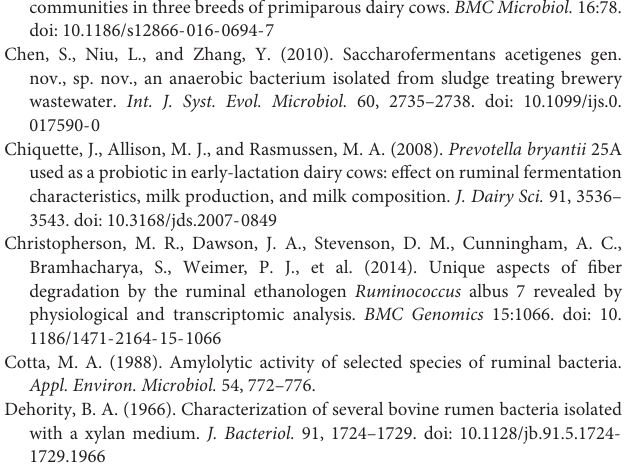
Supplementary Figure 1 | Venn diagram showing OTU distribution. Shared OTUs between milk phenotype-associated (MPA) OTUs (38 OTUs), stable OTUs (176 OTUs), and a total number of 6363 bacterial OTUs, are illustrated in Venn diagram, indicating that only 2 OTUs, assigned to unclassified Firmicutes and unclassified Bacteroidetes, are shared between the MPA and stable OTUs. Supplementary Figure 2 | SCFA proportions over the lactation period. The relative proportions of individual SCFAs (A: Acetate; P: Propionate; B: Butyrate) were plotted against days in milking ranging from day 13 to day 320. Major SCFA components are designated as open circles with distinct colors. Repeatability of individual SCFA proportions (acetate, propionate and butyrate) are 0.19, 0.11, and 0.21,